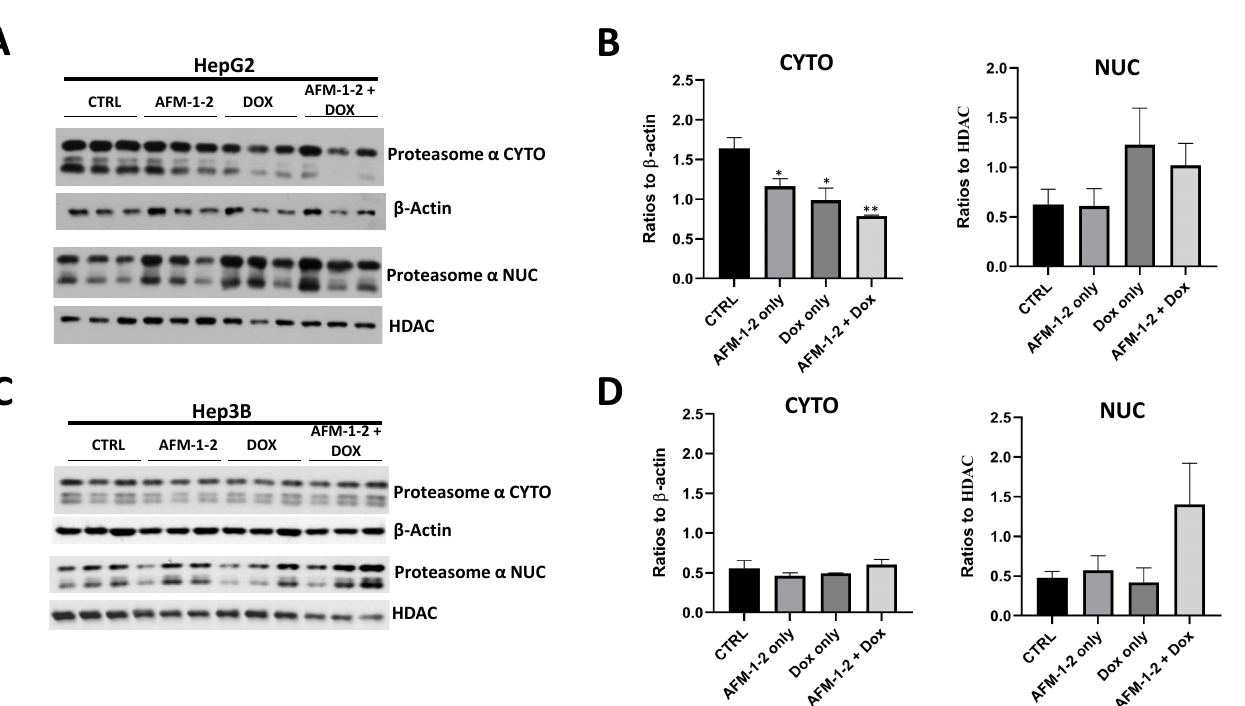
Figure 9. Synergy between Gankyrin inhibition and doxorubicin is related to the nuclear transport of doxorubicin by the 20S proteasome. ( A ) Western blot results of proteasome α in the nuclear and cytoplasmic extracts of HepG2 cells treated with AFM-1 and -2 alone, doxorubicin (abbreviated as Dox in the figure) alone, or in combination. ( B ) Quantitation of proteasome α in the nuclear and cytoplasmic extracts of HepG2 cells treated with AFM-1 and -2 alone, doxorubicin alone, or in combination. A statistically significant decrease in the cytoplasmic expression was seen with AFM-1 and -2 only ( p = 0.044), Dox only ( p = 0.032), and AFM-1 and -2 + Dox ( p = 0.003). There was an increase in the nuclear expression with Dox only and AFM-1 and -2 + Dox; however, it did not reach statistical significance ( p = 0.210 and p = 0.220, respectively). * = p < 0.05 and ** = p < 0.01. ( C ) Western blot results of proteasome α in the nuclear and cytoplasmic extracts of Hep3B cells treated with AFM-1 and -2 alone, doxorubicin alone, or in combination. ( D ) Quantitation of proteasome α in the nuclear and cytoplasmic extracts of Hep3B cells treated with AFM-1 and -2 alone, doxorubicin alone, or in combination. There were no differences in the cytoplasmic expression in Hep3B cells and a trend of increasing in the nuclear expression with AFM-1 and -2 + Dox ( p =